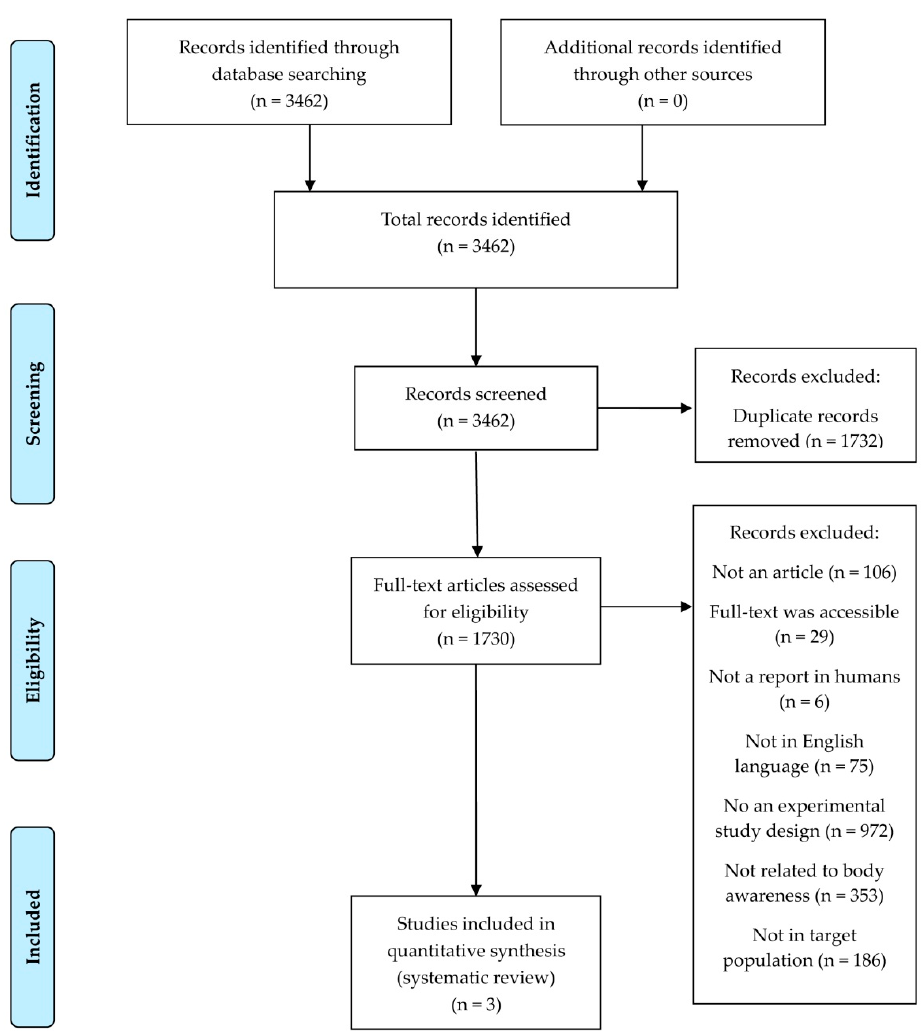
Figure 1. PRISMA flow diagram.